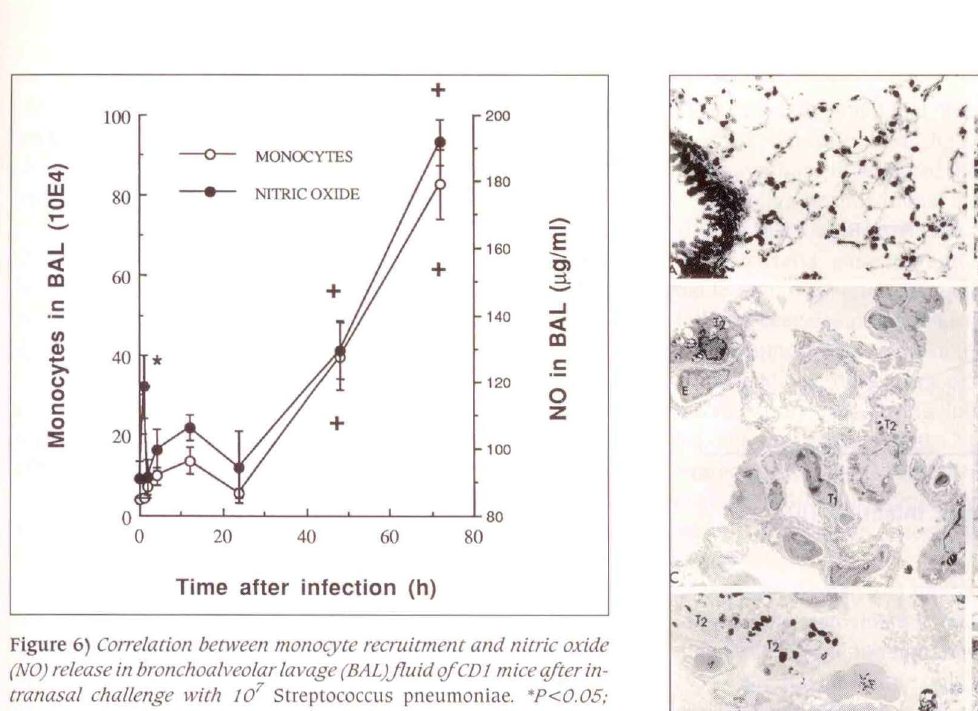
Figure 6) Correlation between mono<yte recruitment and nitric oxide (NO) release in bronchoalveolar lavage (BALJ.fluid qf CDJ mice qfter in tranasal challenge with 10 7 Streptococcus pneurnoniae. *P<0.05;